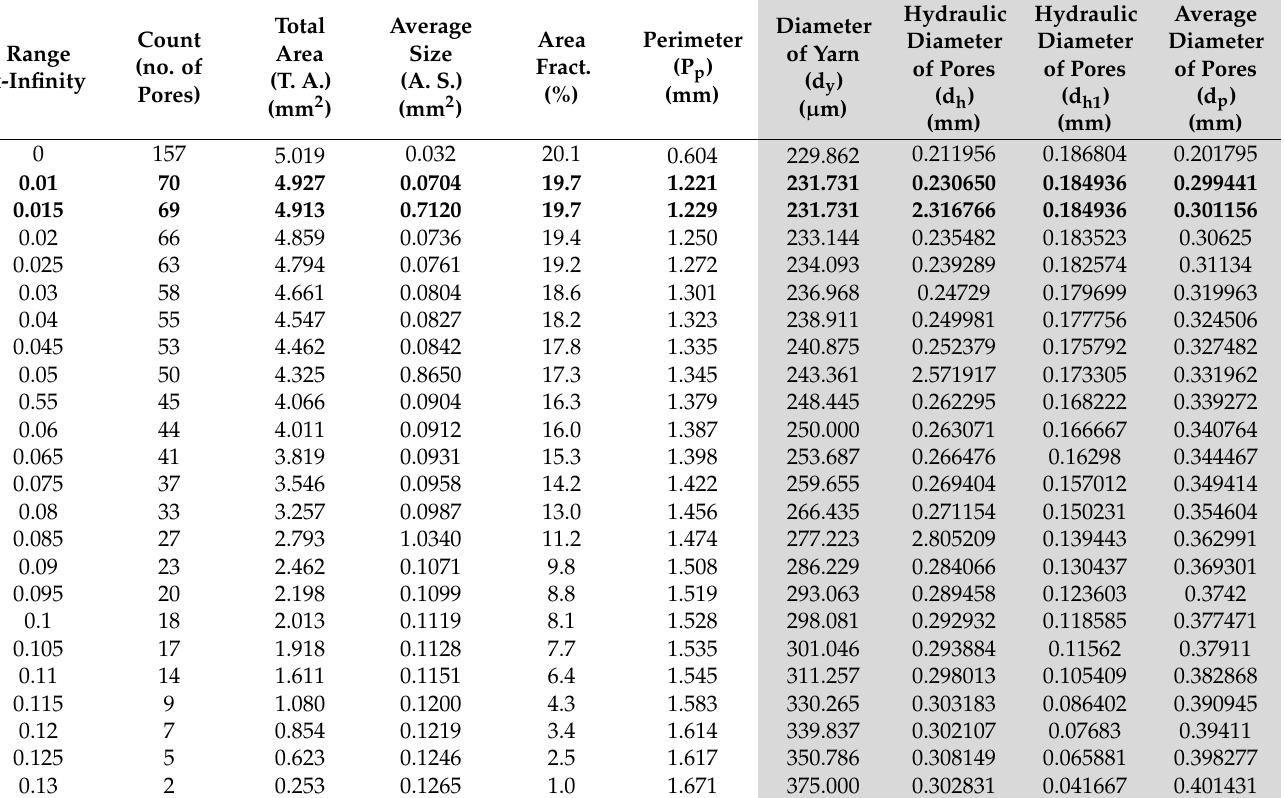
Table 6. ImageJ processed measurements and basic calculation for weft rib